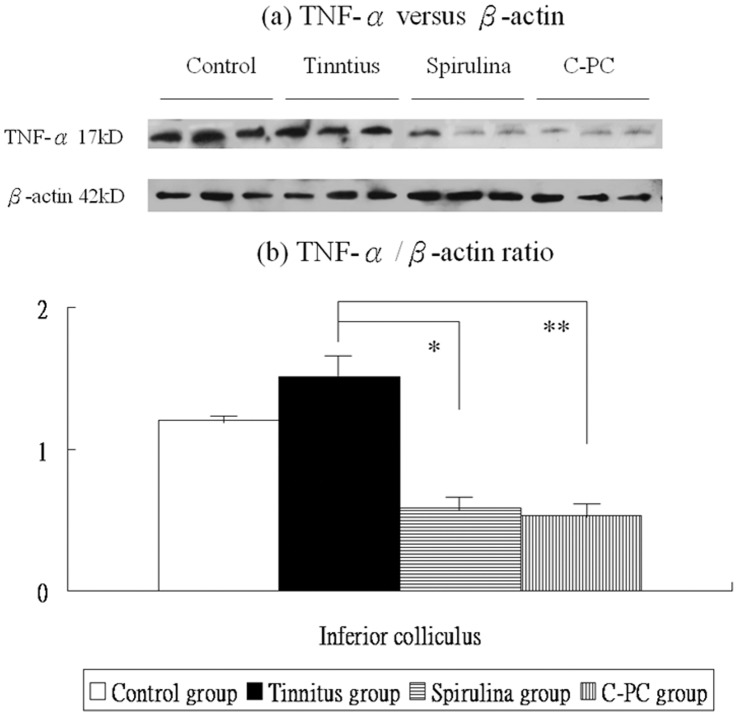
The levels of TNF-α protein expression in the IC (a,b).There are significant differences in these levels among the four groups. The TNF-α mRNA expression were not significantly higher in the salicylate group than the control group. Compared to the tinnitus group, the Spirulina group (*) or C-PC group (**) exhibits significantly reduced TNF-α protein levels in the IC.